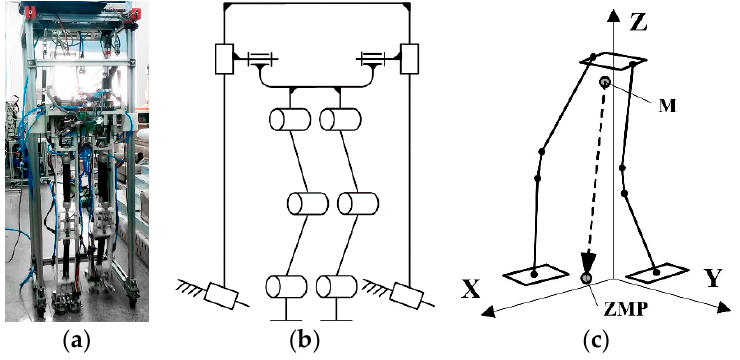
Figure 13. Experimental apparatus of the biped robot. ( a ) Prototype of the biped robot; ( b ) schematic diagram of the biped robot; and ( c ) the coordinate system of the biped robot for ZMP computation.